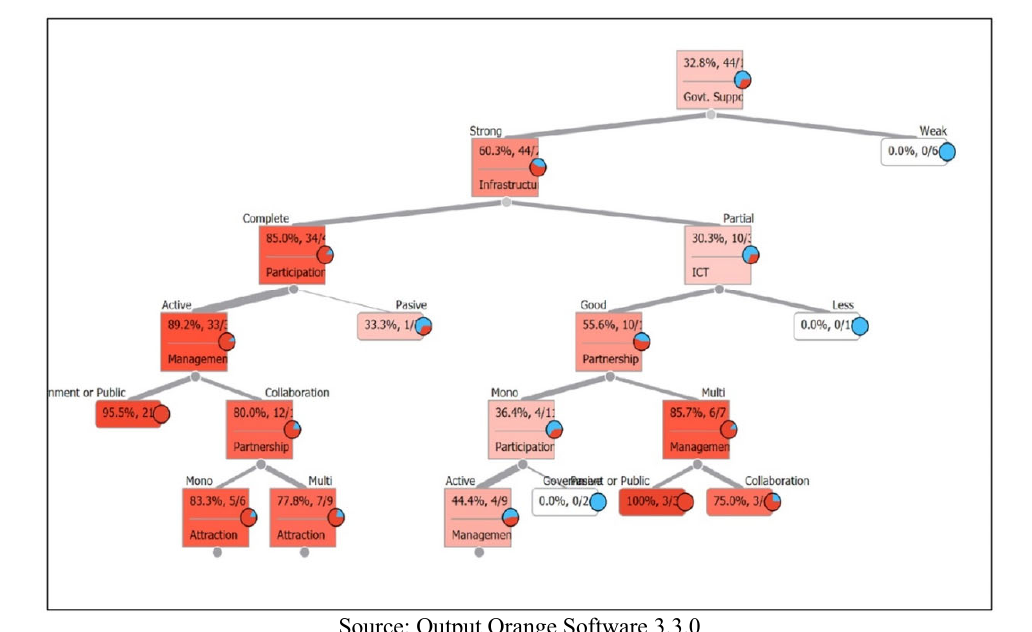
Fig. 2. Determinant Factors of Tourism Village